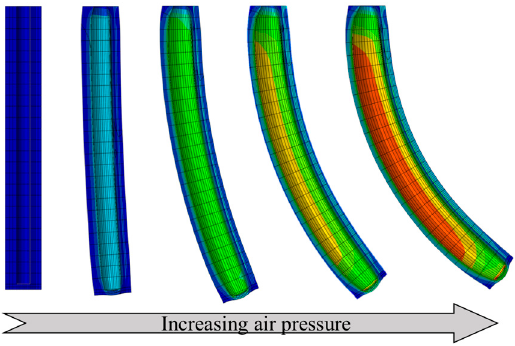
Figure 7. Bending performance of soft bilayer actuator under applied air pressure.